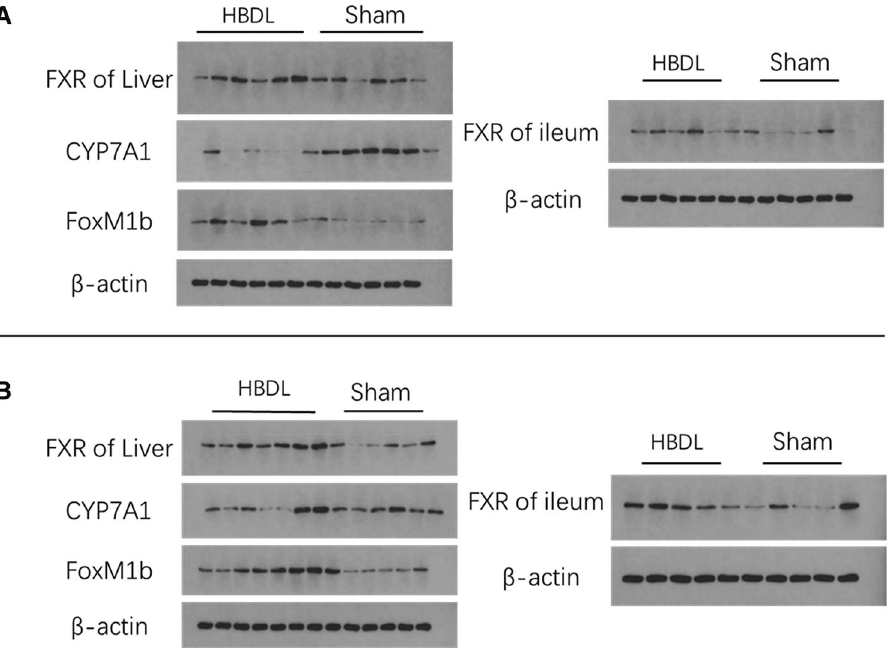
Figure 5. Expression of FXR in the livers, FXR in the ileum, CYP7A1 in the livers and FoxM1b in the livers of HBDL mice at the protein levels at different time points. Representative blots of HBDL (left side of membranes) and Sham (right side of membranes) at the first day after the operation ( A ) and the first week after the operation ( B ) is indicated.